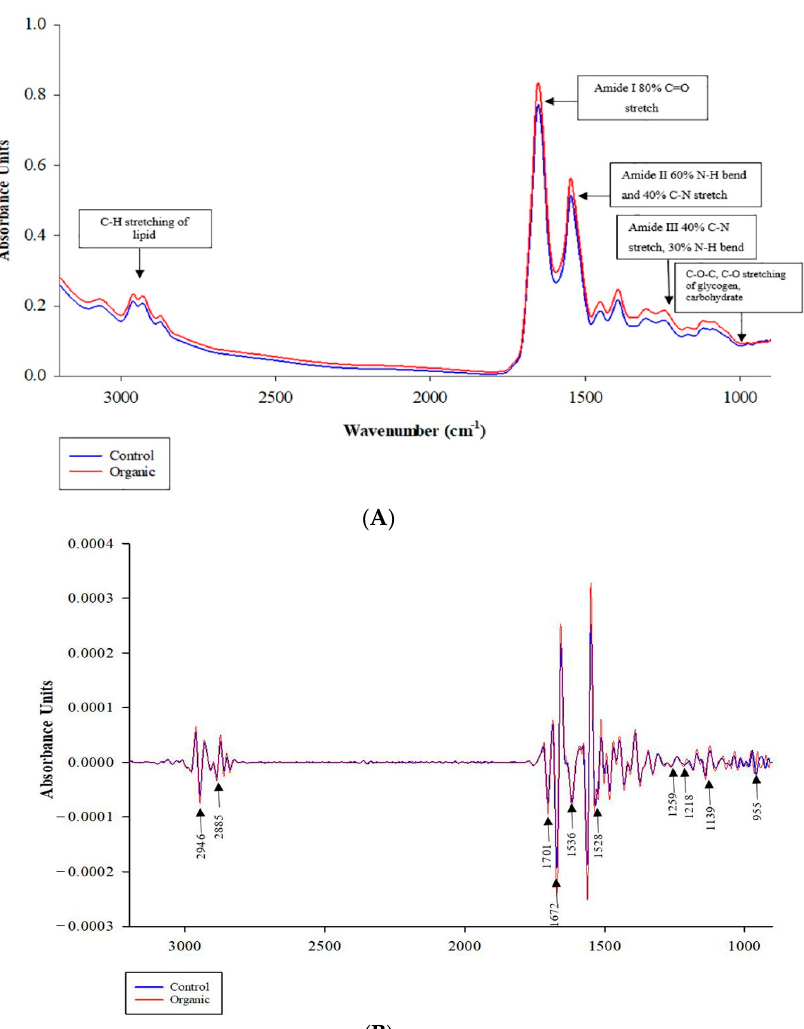
Figure 1. Average SR-IR spectra of original ( A ) and second derivative ( B ) from KRC chicken breast meat between control and organic raising systems. Infrared spectra were collected in the spectral range of 4000 to 900 cm − 1 , resolution 4 cm − 1 based on 300 spectra per treatment. 3000 to 2800 cm − 1 (CH stretch of lipid); 1740 cm − 1 (C=O ester of lipid); 1700 to 1600 cm − 1 (amide I); 1600 to 1500 cm − 1 (amide II); 1338 cm − 1 (amide III); and 1250 to 900 cm − 1 (carbohydrate and glycogen) parameters used for the collected spectra.